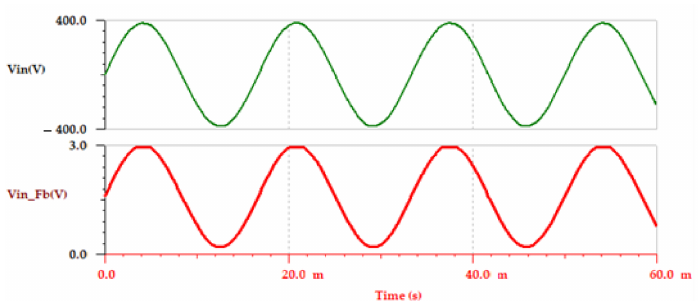
Figure 22. Isolated AC voltage sensor voltage curves with input voltage of 220 Vrms.